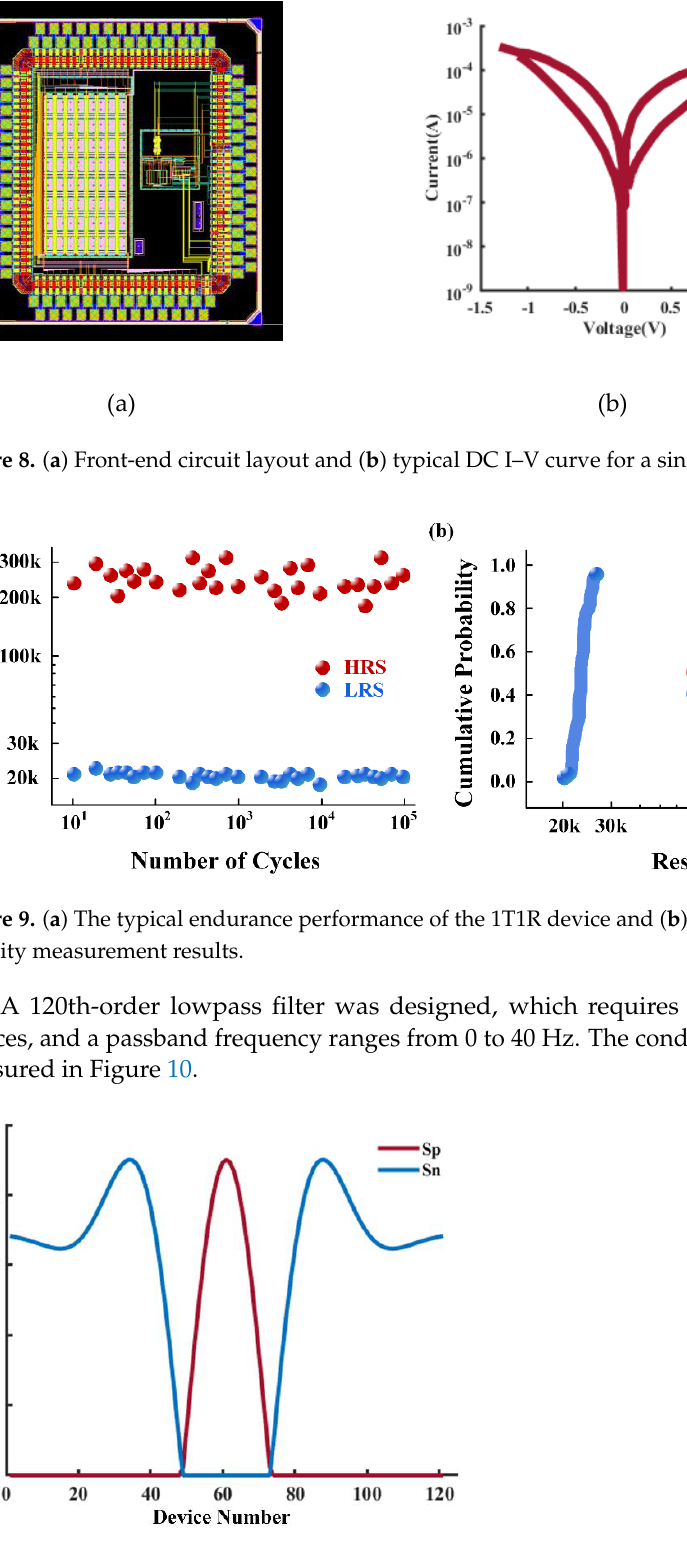
Figure 10. Conductance map for the lowpass FIR filter.